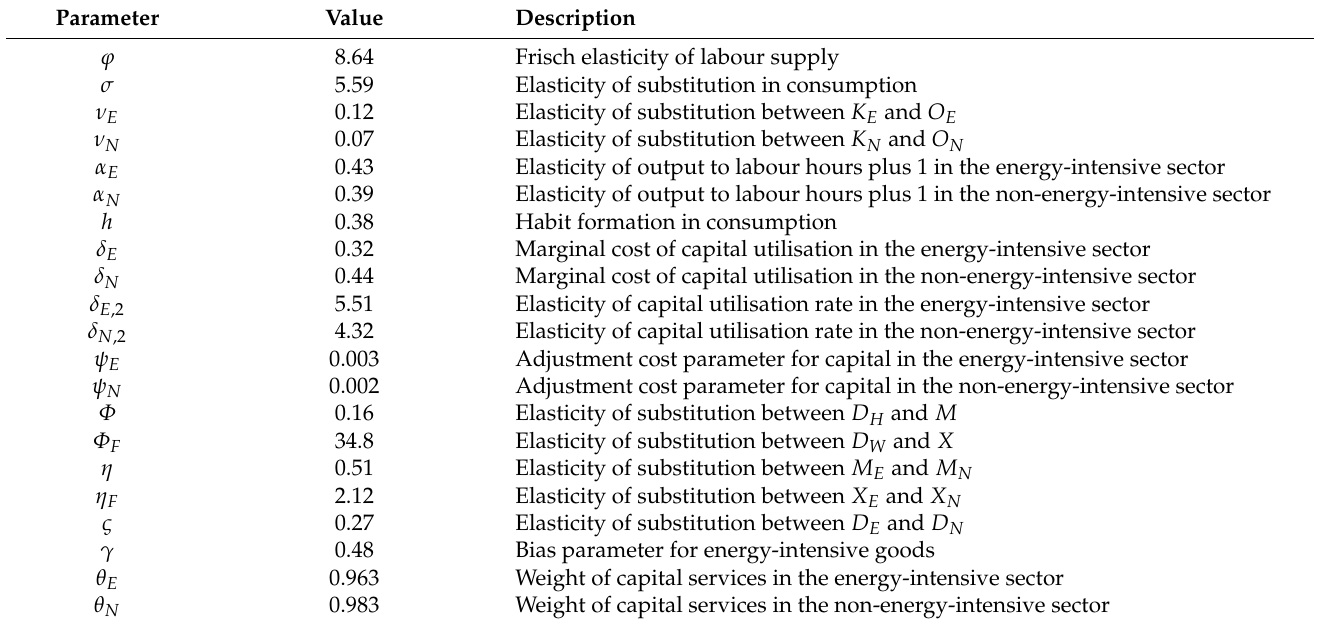
Table 1. Estimates of structural parameters by indirect inference.